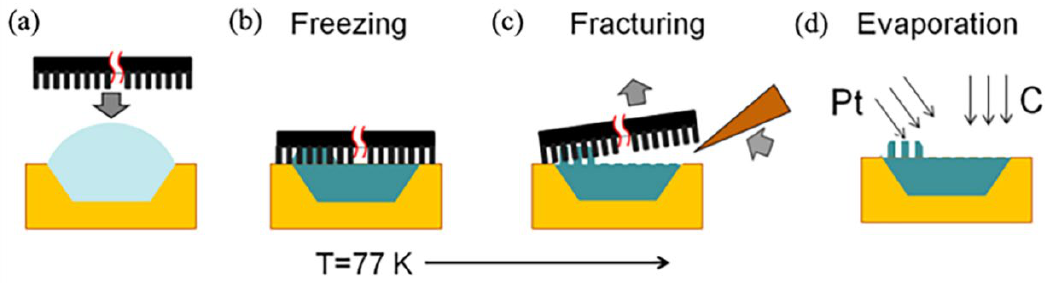
Figure 13. Schematic illustration for the freezing fracture methodology. ( a ) Before freezing, ( b ) rapid freezing of the pure water, ( c ) fracturing, ( d ) surface coated by thin platinum and carbon layers. Reprinted with permission from Ref. [123]. Copyright@2013, Langmuir.